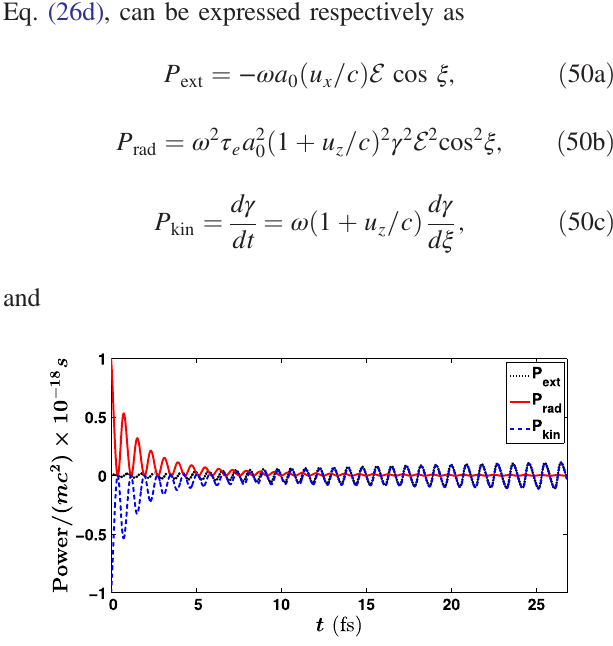
FIG. 1. P , P , and P plotted vs time t for a uniform ext rad kin linearly polarized laser with angular frequency ω ¼ 2 × 10 15 s − 1 and strength a 0 ¼ 100 ( E ¼ 1 ), and an electron with initial relativistic factor γ 0 ¼ 1000 .